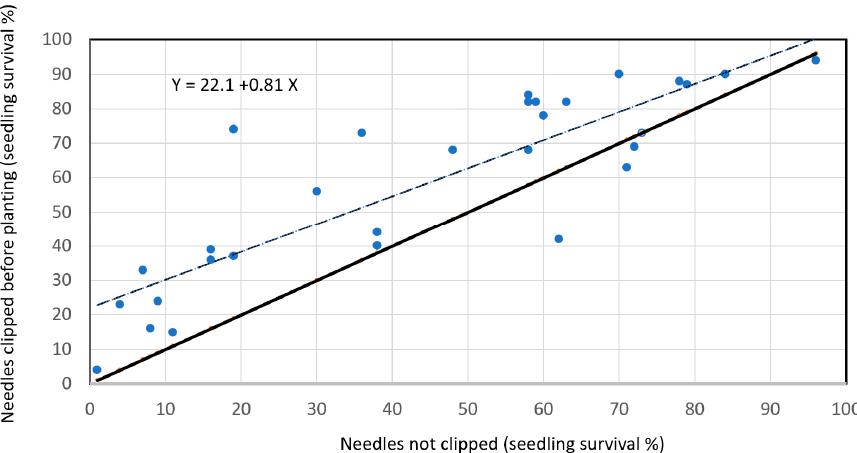
Figure 14. Comparison in survival between clipped and nonclipped longleaf pine seedlings [94]. The dashed line represents the regression equation ( n = 30), and the solid line represents equal survival of the two treatments. Points above the solid line represent cases where clipping needles increased survival. Data from [94]. p > |t| = 0.0001 for intercept and 0.0001 for slope; R 2 = 0.74.